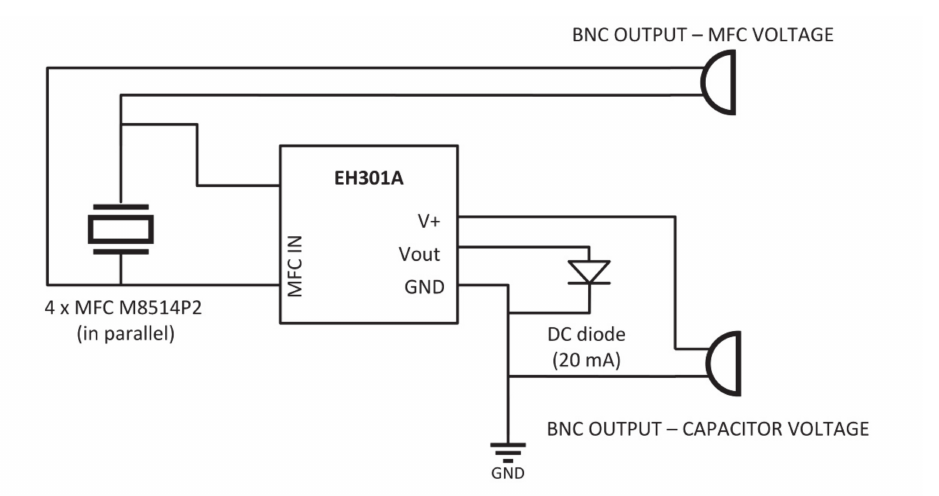
Figure 10. Experimental set-up.